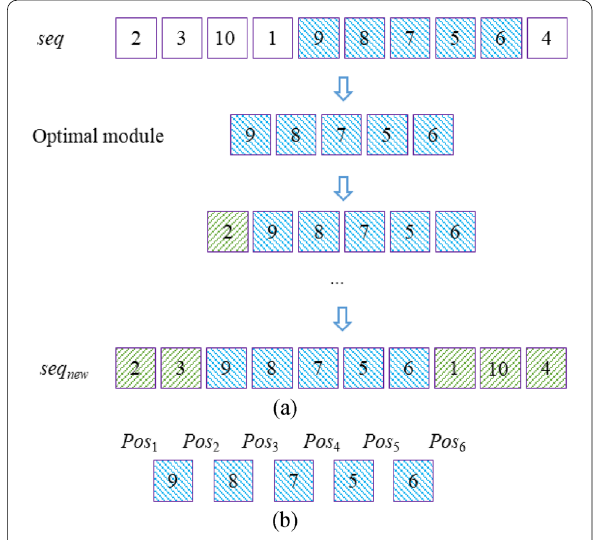
Figure 4 Module-based insert neighborhood structure: ( a ) a schematic diagram of MBI, ( b ) the set of positions in the optimal module